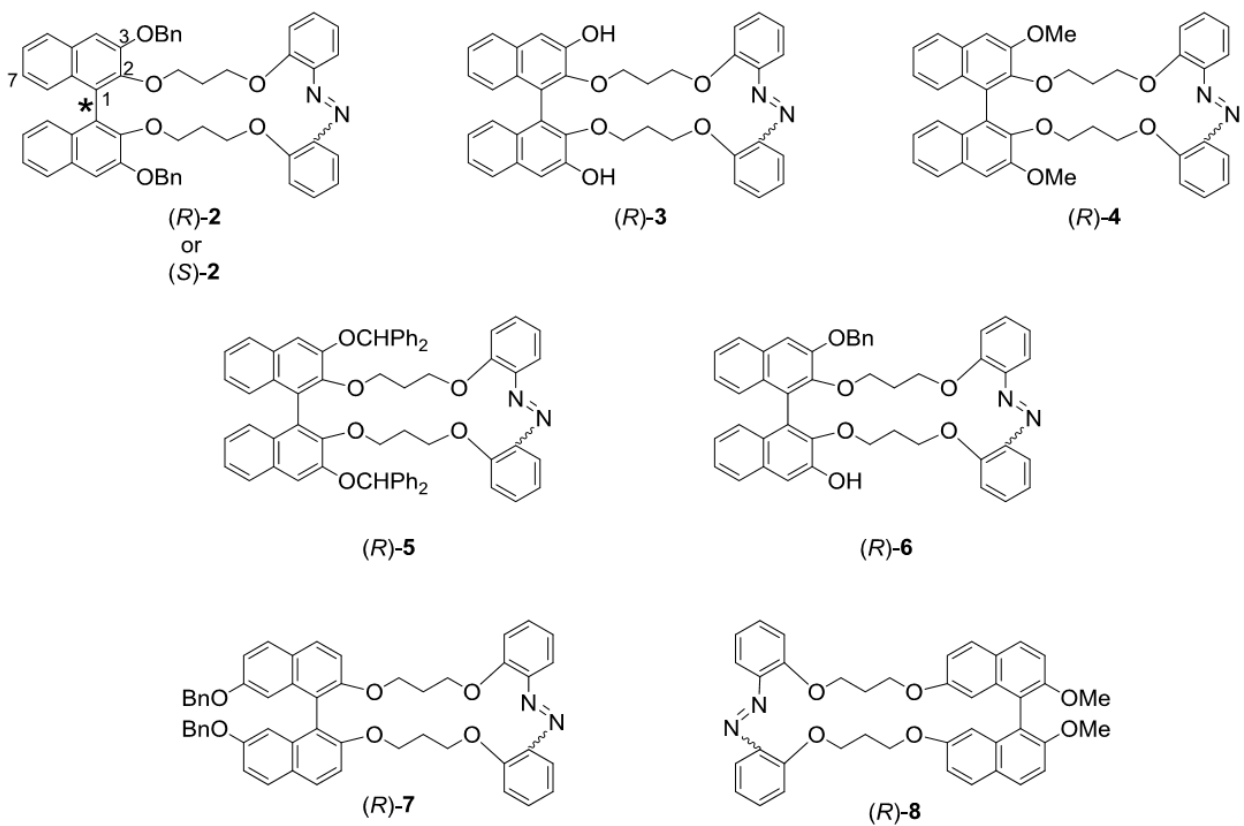
Figure 3. Opically active binaphthyl-azobenzene cyclic dyads 2 – 8